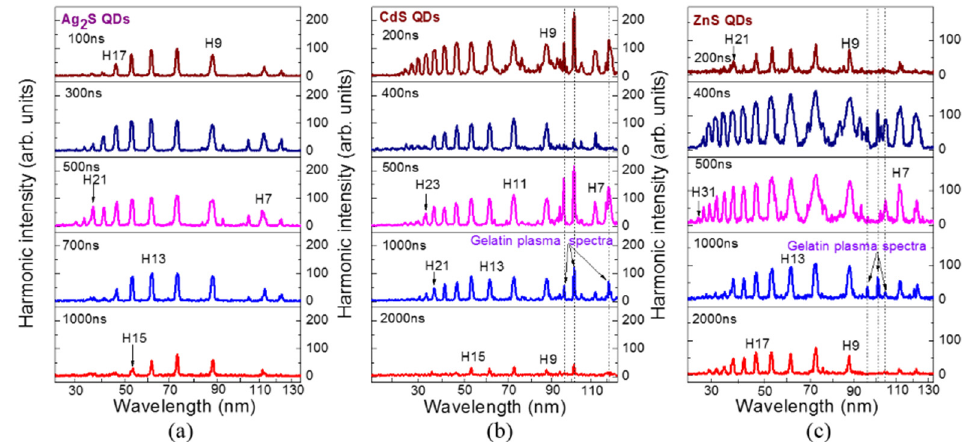
Figure 11. HHG in ( a ) silver sulfide QDs, ( b ) cadmium sulfide QDs, and ( c ) zinc sulfide QDs. Reprinted with permission from Ref. [43], 2018, Optica Publishing Group.